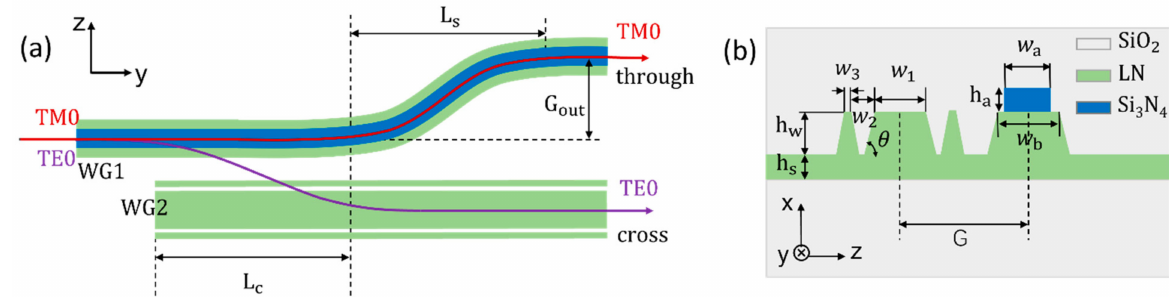
Figure 1. Schematics of proposed PBS; ( a ) top view and ( b ) cross-section